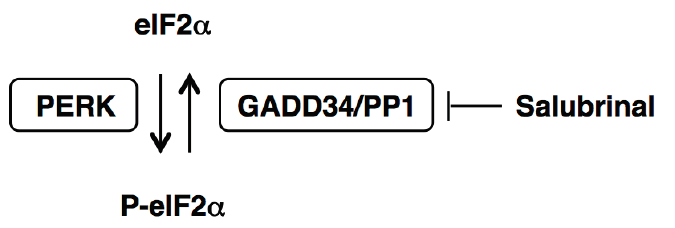
Figure 1. Inhibition of eIF2 α dephosphorylation by salubrinal. During ER stress, the double-stranded RNA-activated protein kinase-like ER kinase (PERK) phosphorylates the eukaryotic translation initiation factor 2 alpha (eIF2 α ). Salubrinal prevents eIF2 α dephosphorylation by inhibiting the protein complex GADD34/PP1, which consists of the general cellular serine/threonine protein phosphatase 1 (PP1) and the non-enzymatic cofactor growth arrest and DNA damage gene 34